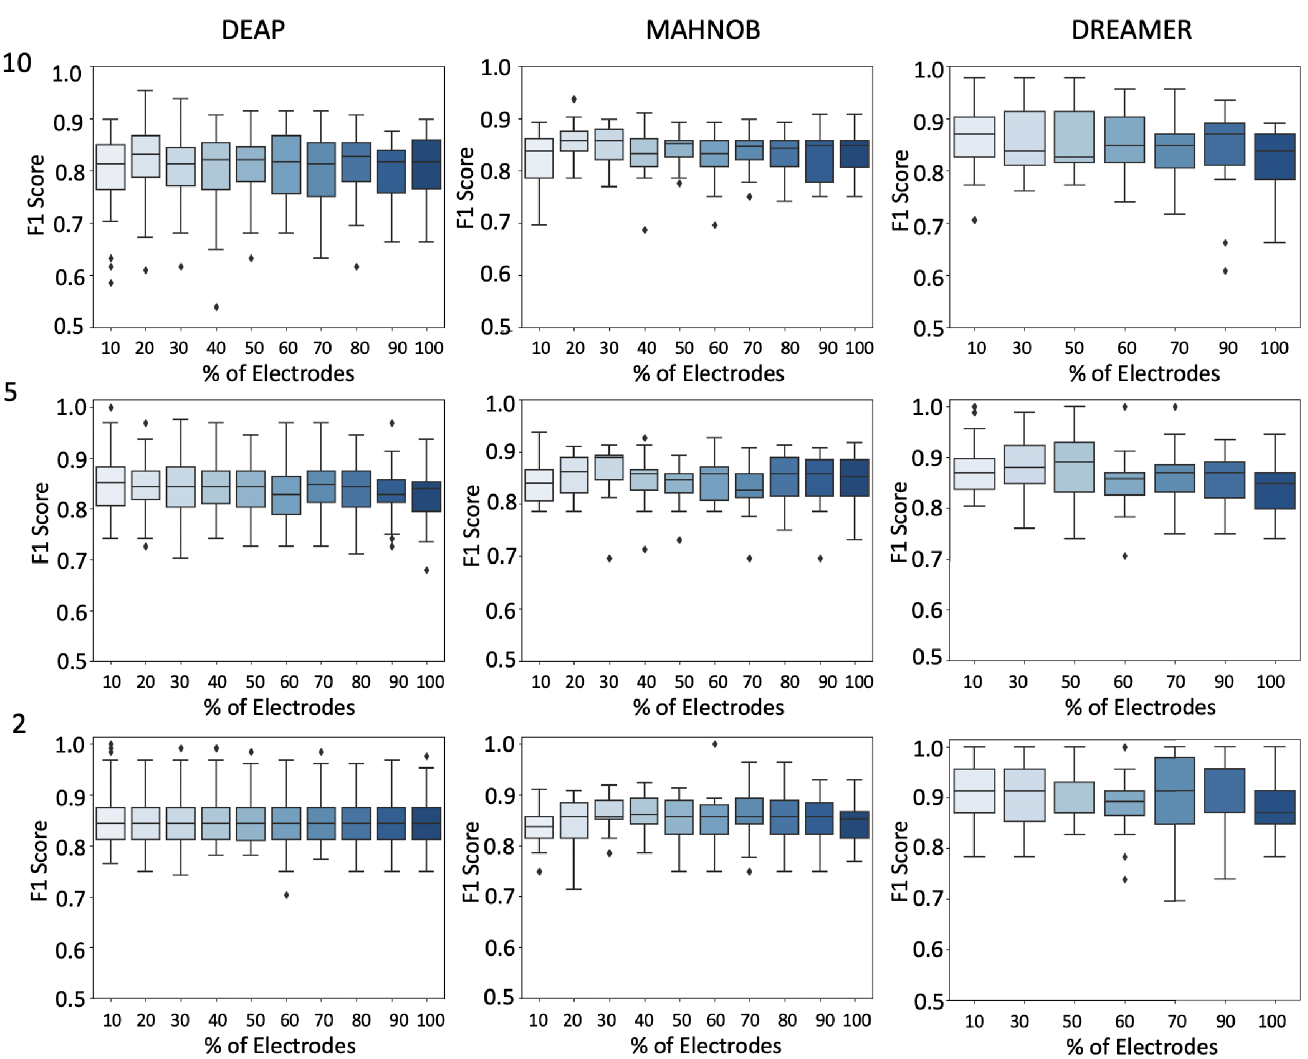
Fig 5. Valence: F1 scores for various ranked electrode channels selections (10%,20%, ... ,100%) on the x-axis, and F1 score on the y-axis. We show datasets vertically, and epoch sizes (10s, 5s, and 2s) horizontally. Each box plot depicts f1 scores across trials.